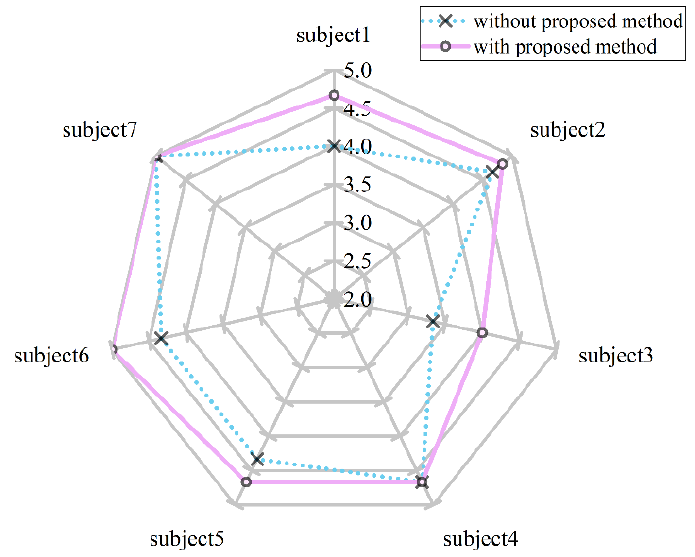
Figure 13. Average user satisfactions with and without proposed method: selecting tasks.